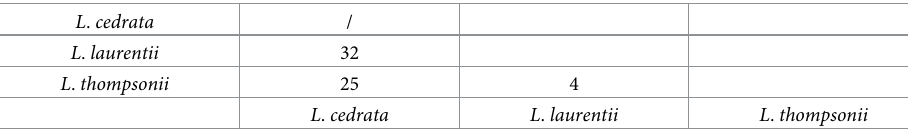
Table 11. SNP variation in plastid intron regions among Leplaea